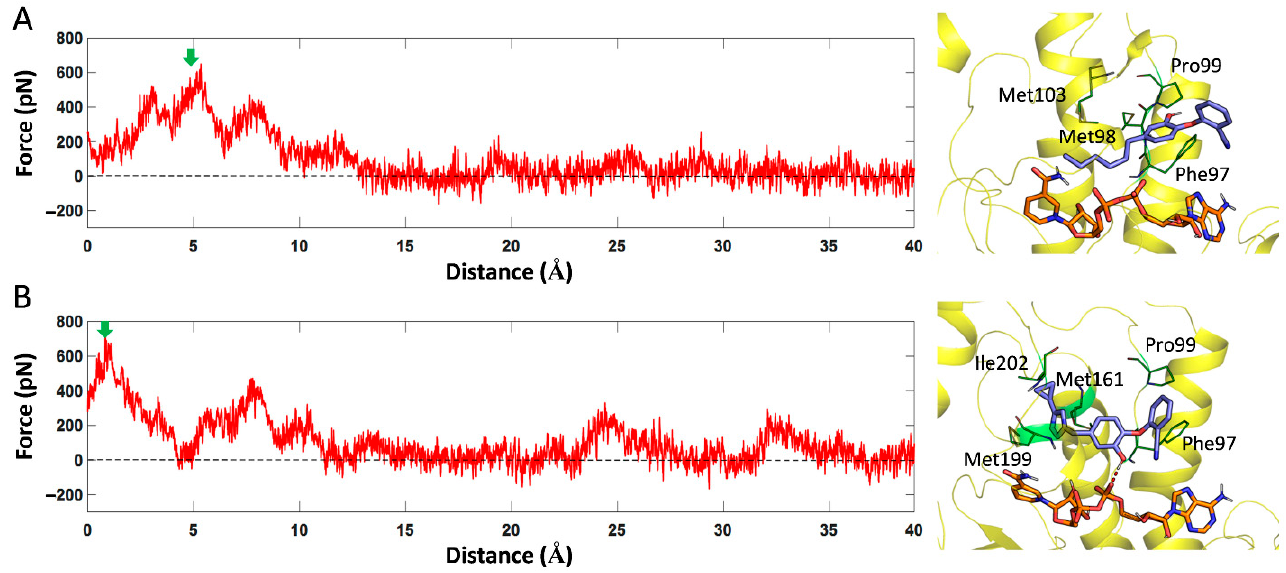
Figure 8. The force profiles of PT119 ( A ) and PT506 ( B ) over the reaction coordinate along path2 channel. The structures at the maximum force (green arrow) were extracted and displayed on the right side of the